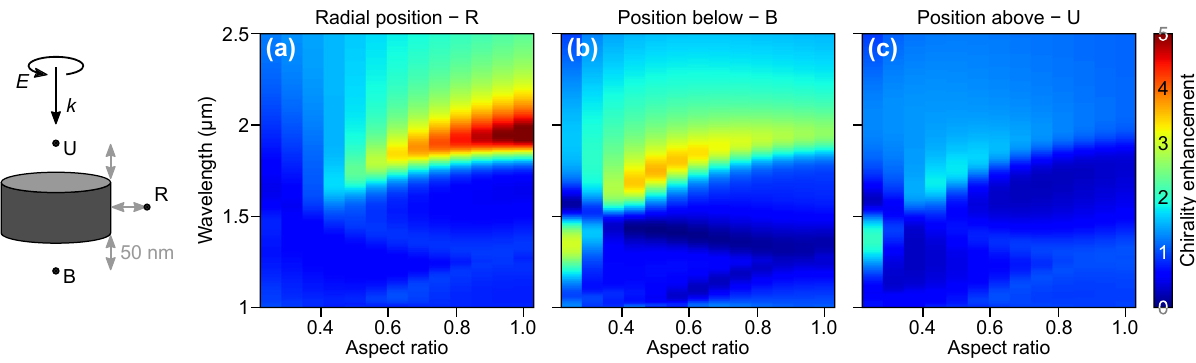
Figure 3: Chirality enhancement spectra for high-index nanodisks calculated along specific directions: (a) in the radial direction, (b) in z below the disk and (c) in z above the disk at a distance of 50 nm away from each particle. The positions are marked in the cartoon on the left. Here, semi-analytical expressions obtained in the dipole approximation are used. Therefore, quadrupole maxima are not present. Note how maxima of chirality enhancements appear for different aspect ratio for each direction. Also, maximal attainable value for the z direction is smaller than that in the radial